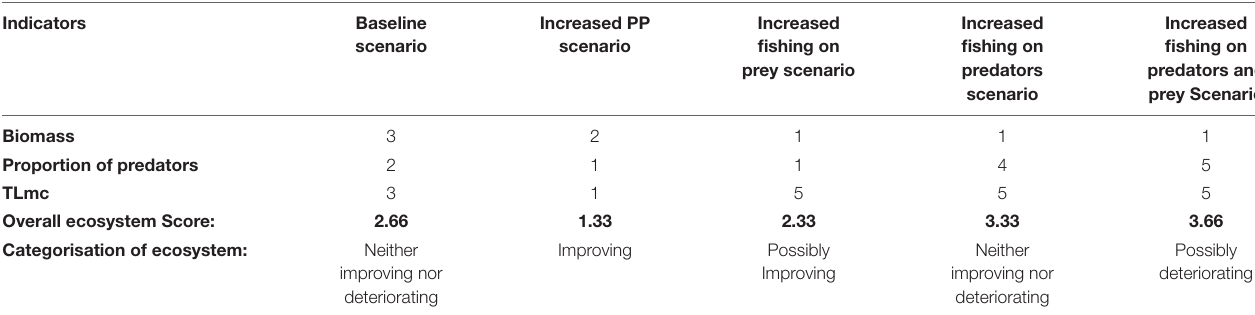
TABLE 4 | Summary of indicator trend